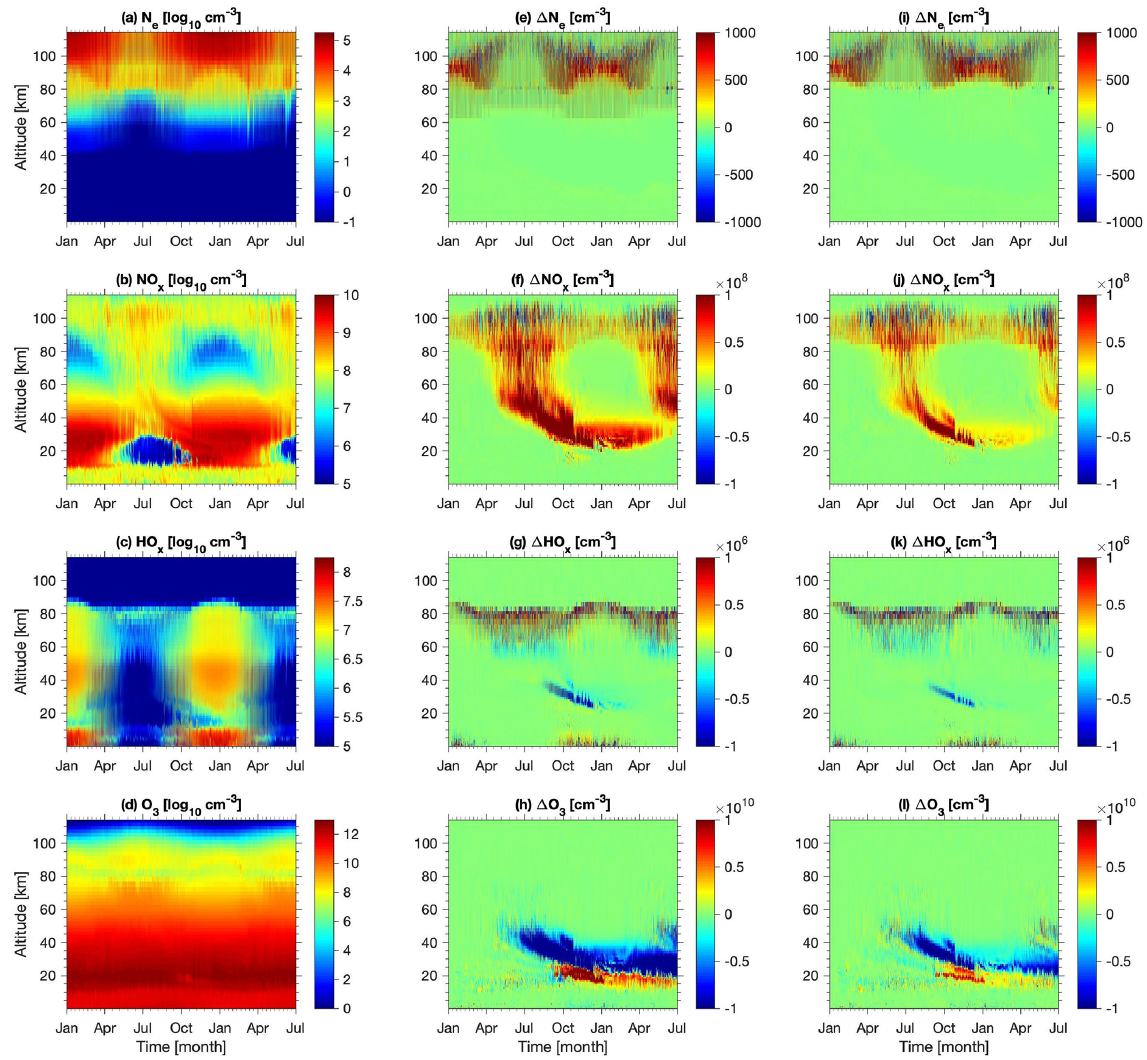
Figure 3. Model results for a selected location in the Southern Hemisphere: Halley Research Station in Antarctica (75.6 ◦ S, 26.6 ◦ W). For a description of panels, see the caption of Fig.